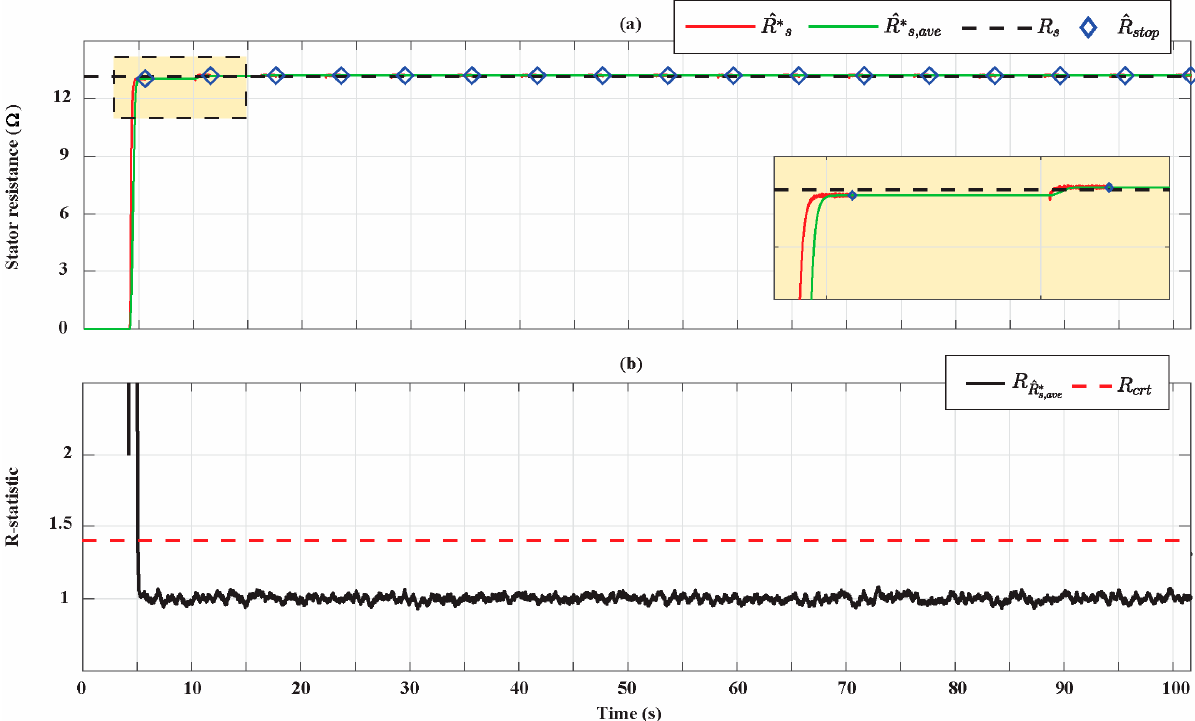
Figure 11. ( a ) Stator resistance estimation for the Bonfiglioli 65; ( b ) R-statistic analysis of the stator resistance estimation.